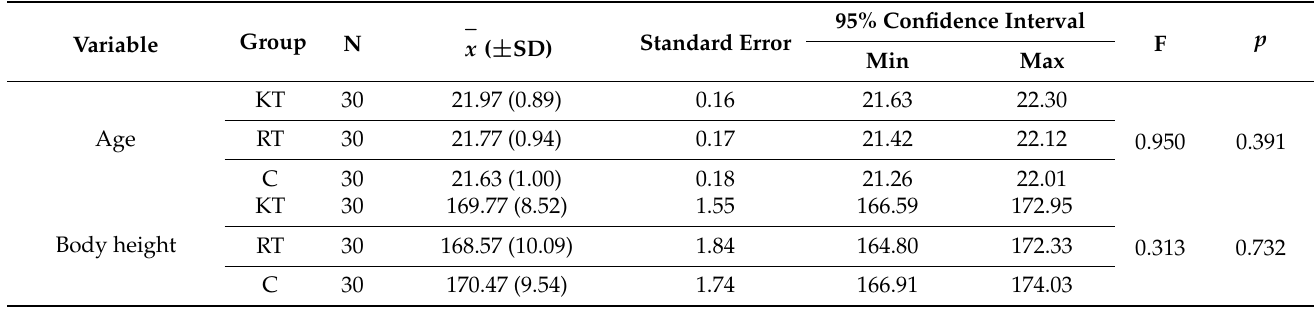
Table 2. Homogeneity of the groups under study (N =